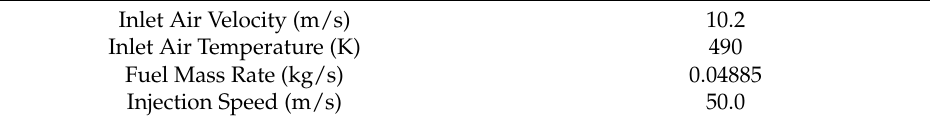
Table 2. Key parameters of the helicopter engine LES.